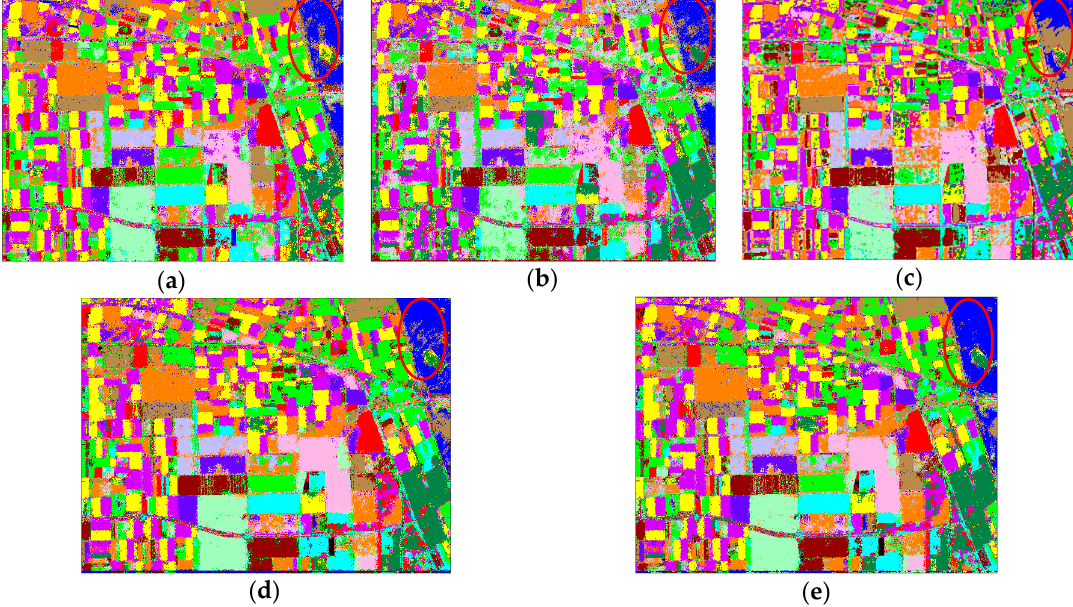
Figure 5. The classification results of the Flevoland dataset from AIRSAR. ( a ) SVM, OA = 0.8708; ( b ) SRC, OA = 0.8231; ( c ) WC, OA = 0.8504; ( d ) MAE, OA = 0.9304; ( e ) SPLMAE, OA = 0.9473.